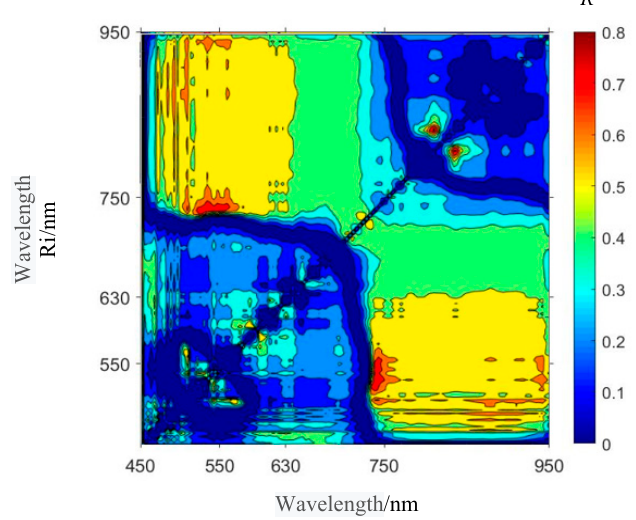
Figure 4. Contour maps of R 2 between disease index and NDSI.